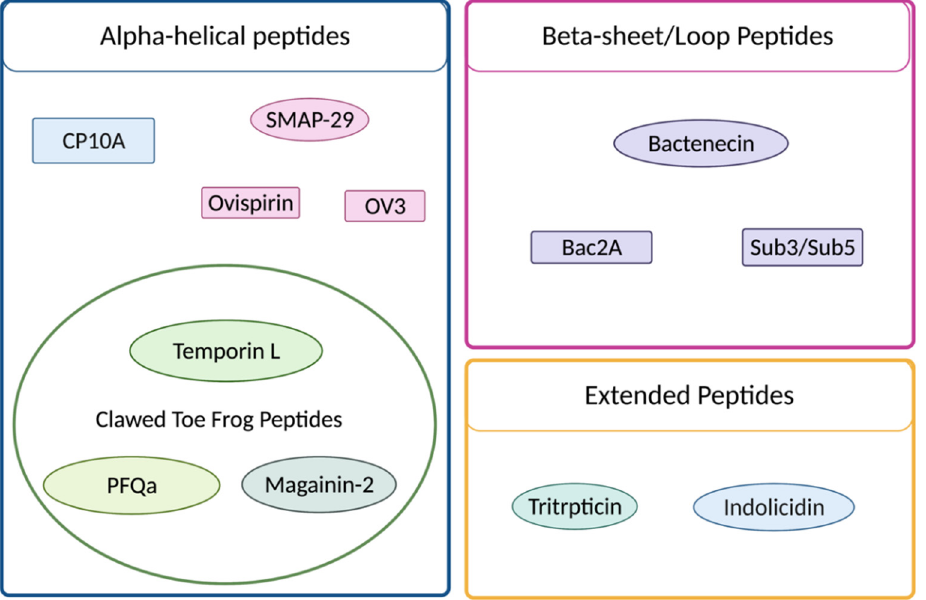
Figure 2. Selected peptides sorted by structure. Ovals represent naturally derived peptides and rectangles represent rationally designed derivatives. Parental and derivative peptides are sorted by color with CP10A being a derivative of indolicidin, Bac2A and Sub3/Sub5 being derivatives of bactenecin and ovispirin and OV3 being derivatives of SMAP-29. The clawed-toe frog peptides are further segregated by a green circle; all other peptides are cathelicidin peptides. Tritrpticin is classified as an extended/ β -turn peptide.